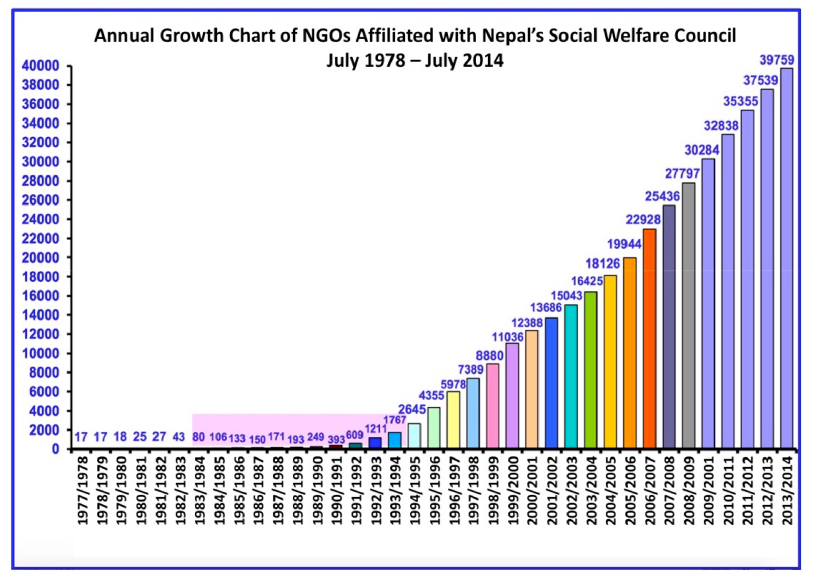
Figure 1. The monotonic rise of NGOdom in Nepal. Source: Adapted from Social Welfare